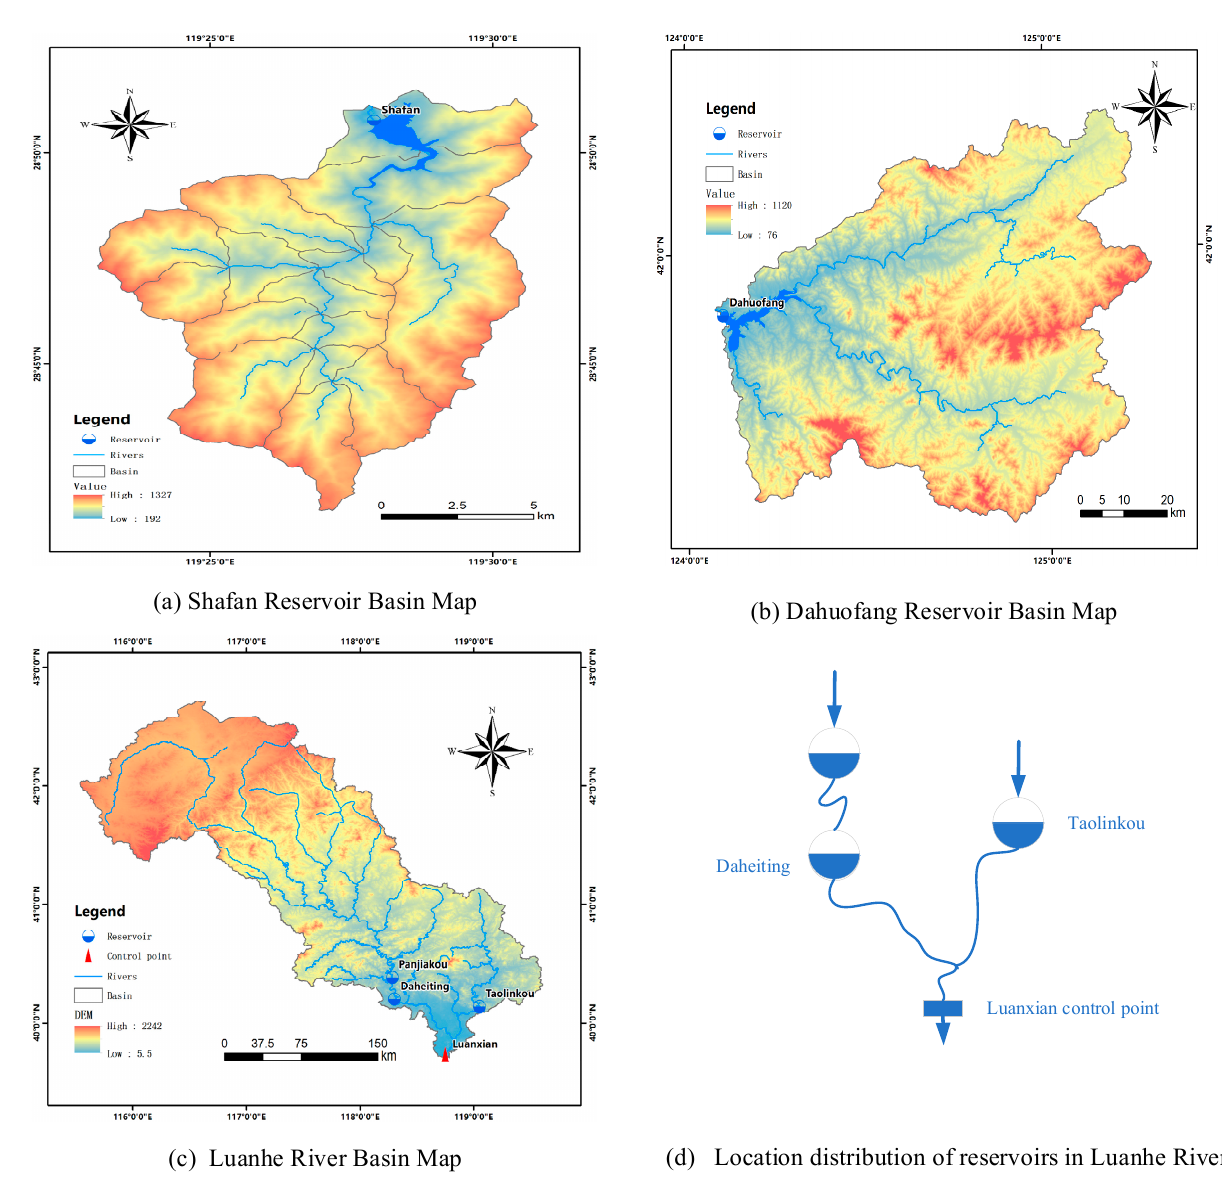
Figure 2. Reservoir basin maps of the study areas. Table 5. Basic characteristics of reservoirs in Luanhe River. Characteristic